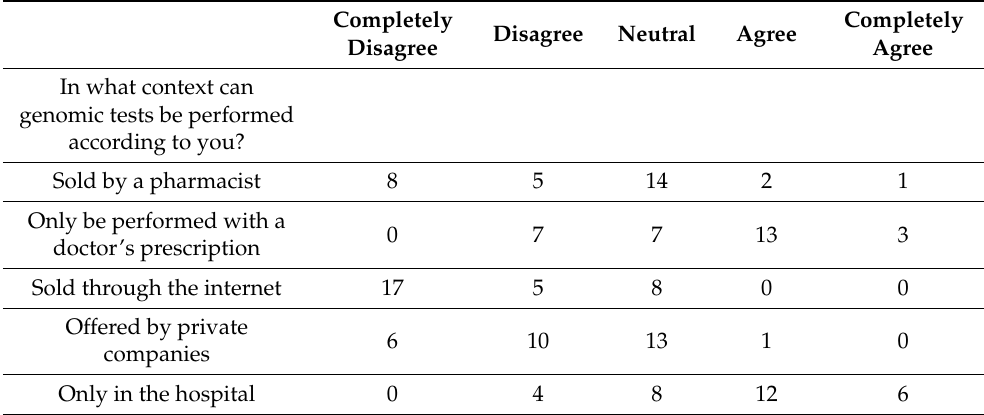
Table 10. Respondents’ preferred context for the implementation of genomic medicine (pre, n =